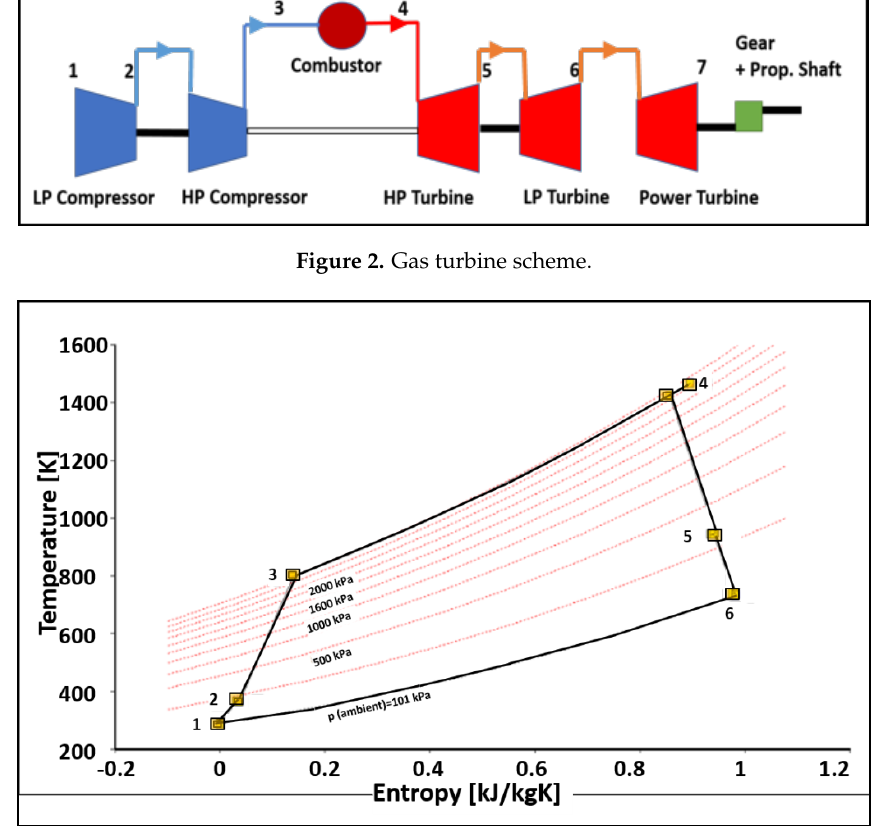
Figure 3. Thermodynamic cycle at the design point.